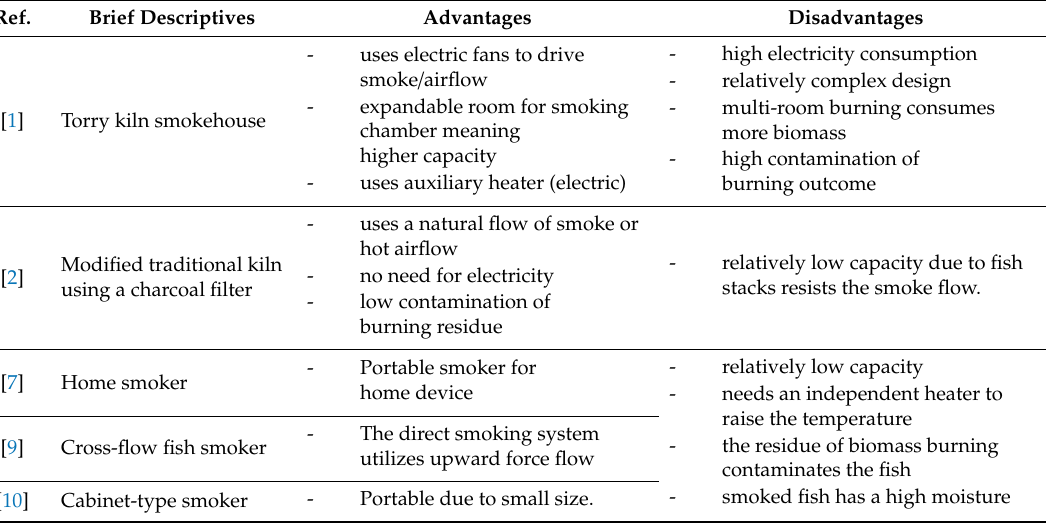
Table 1. A comparison of smokehouse designs.